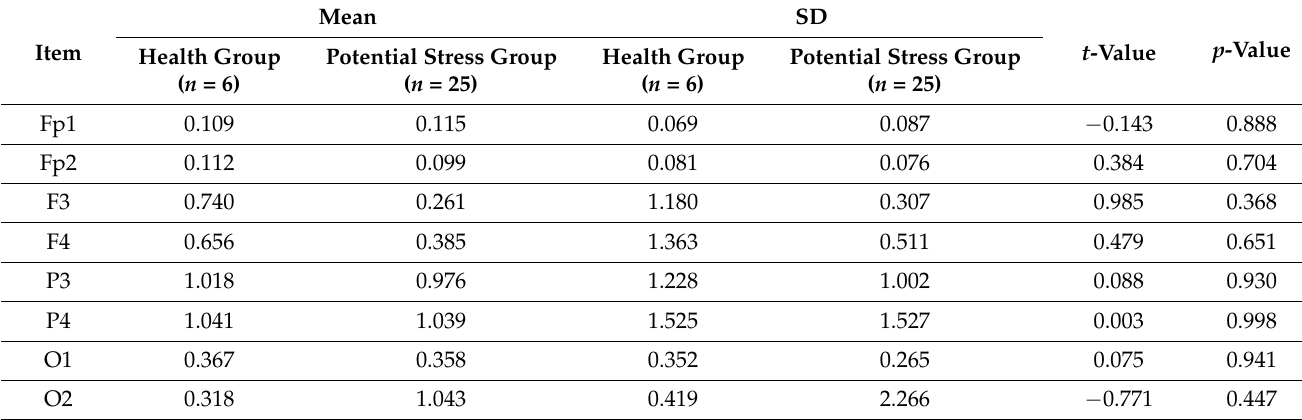
Table 1. Intergroup homogeneity test for background EEGs.